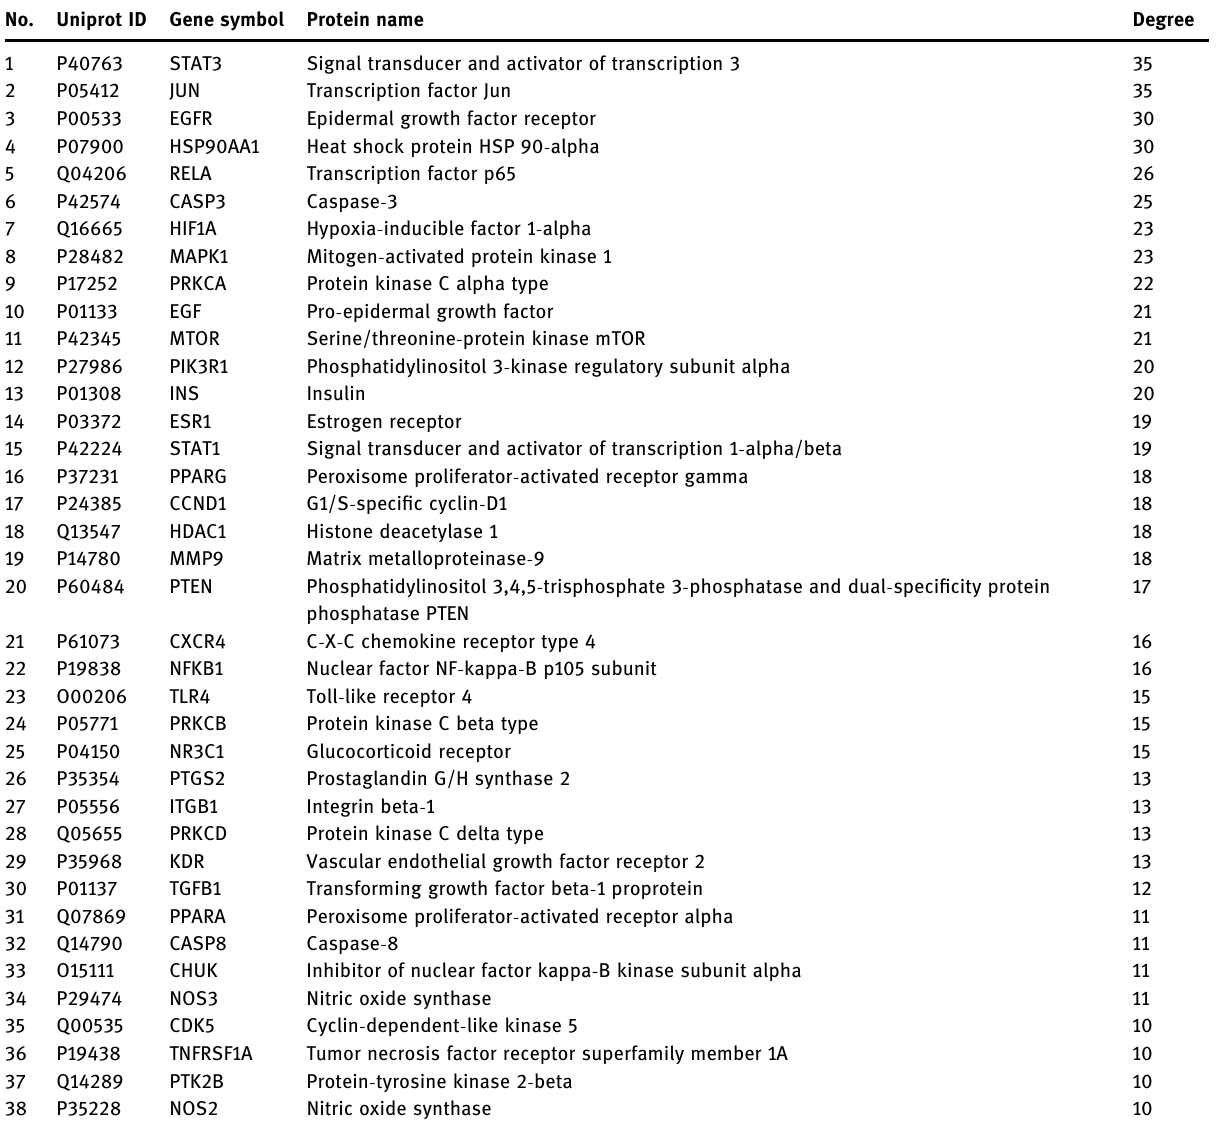
Table 3: Information on 38 core targets No. Uniprot ID Gene symbol Protein